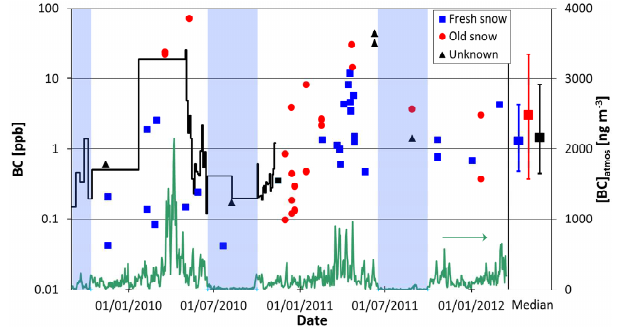
Figure 2. Time series of measured BC concentration in surface snow samples from the Khumbu Valley. The samples were clas- sified into fresh (blue), old (red), and unknown snow (black). The symbols on the right show median concentrations for fresh (blue), old (red), and all snow samples (black). The error bars correspond to the 25th and 75th percentile. Shaded blue areas indicate the mon- soon periods 2009, 2010, and 2011 over Nepal according to Tyagi et al. (2010, 2011) and Tyagi and Pai (2012). The black line corre- sponds to the BC concentration for the period between 1 September 2009 and 8 November 2010 season determined in the Mera ice core (Ginot et al., 2013) with the surface snow concentration from 11 November 2010 shown as black squares. The green line shows the atmospheric BC concentrations measured at